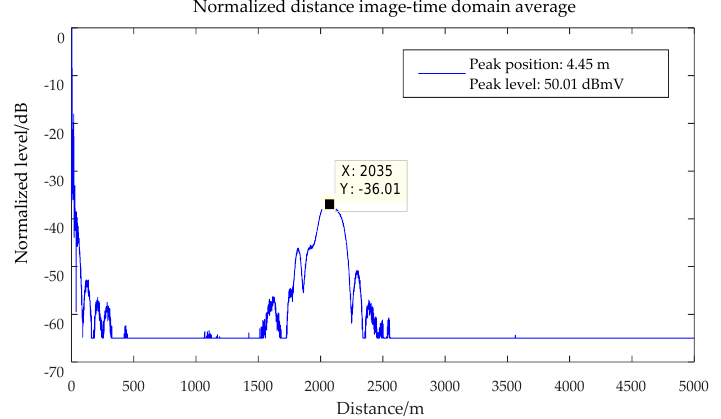
Figure 2. The IMFA-3 signal imaging ( ∆ f 1 = − 0.18 GHz and ∆ f 2 = − 0.36 GHz). Figure 2. Third − order intermodulation false alarm signal imaging (Δ f 1 = −0 .18 GHz and Δ f 2 = −0 .36 GHz). Figure 2. Third − order intermodulation false alarm signal imaging (Δ f 1 = −0 .18 GHz and Δ f 2 = −0 .36 GHz).